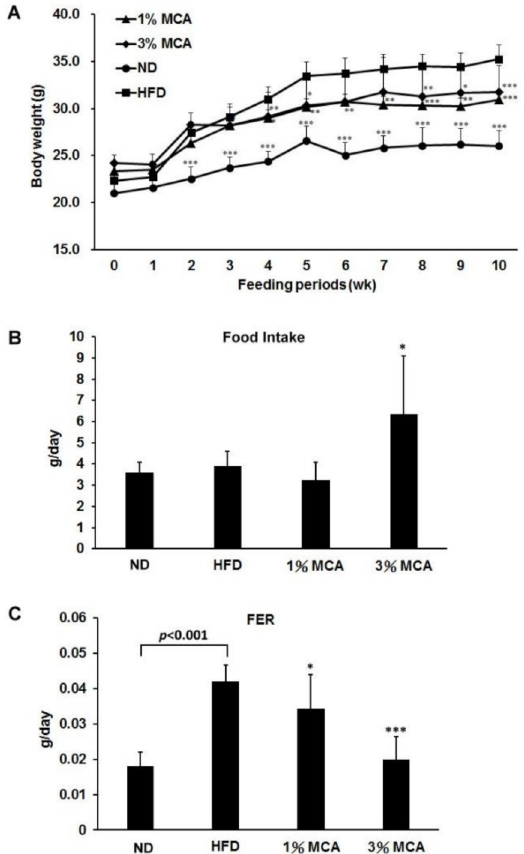
Figure 1. The effect of Momordica Cochinchinensis Aril (MCA) on body weights and food intake in high-fat diet (HFD)-fed mice. ( A ) Changes in body weight. ( B ) Food intake. ( C ) Food efficiency ratio (FER). Data are shown as means ± standard error of the mean (SEM). HFD vs. MCA, * p < 0.05; ** p < 0.01; *** p <